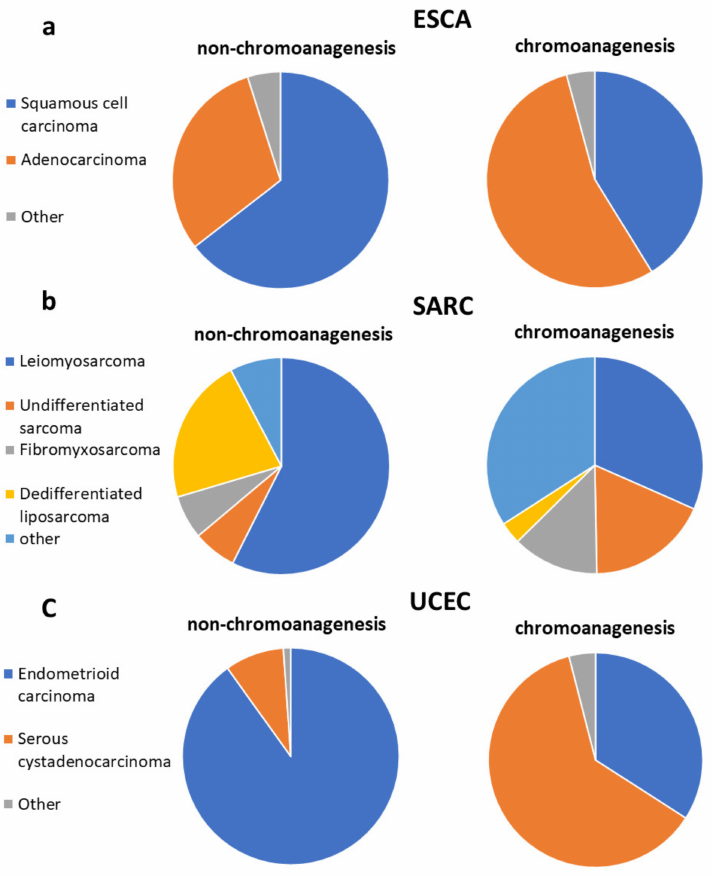
Figure 7. Chromoanagenesis morphological distribution. Pie charts representing the morphology distribution in chromoanagenesis and non-chromoanagenesis samples for ( a ) ESCA, ( b ) SARC, and ( c )